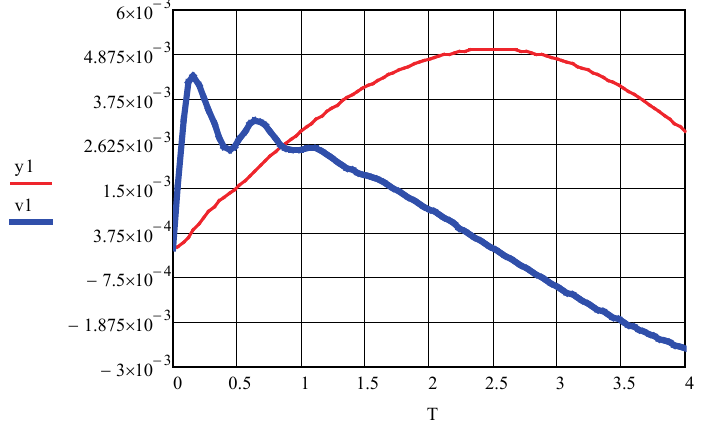
Fig. 7. Amplitude and speed of displacement of the unsprung weight at V = 2.5 m/sec, A = 0.001